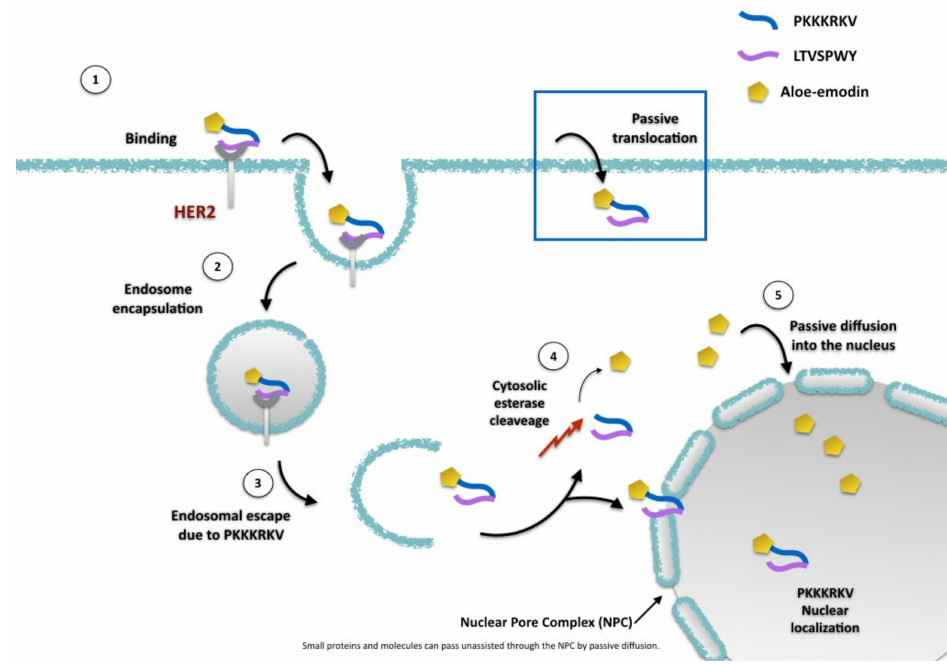
Figure 7. This scheme provides a speculative picture of the events that lead the peptide–aloe conjugate to be internalized within cells, based on the data obtained in this study and of the known mechanisms of uptake acquired from the literature.